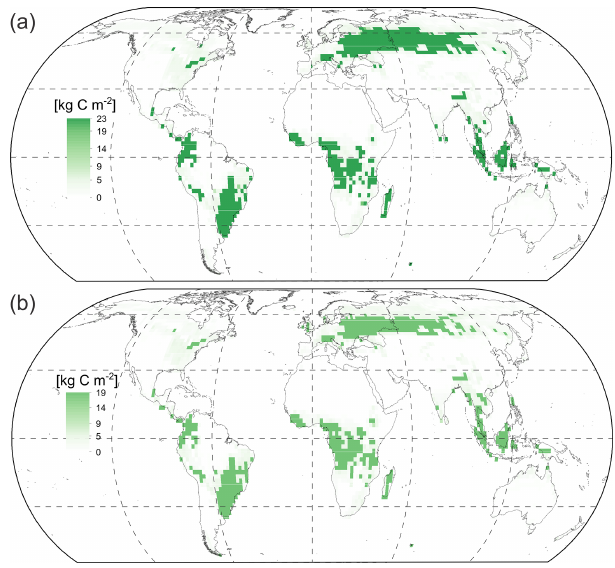
Figure 2. Carbon sequestered in different afforestation– reforestation scenarios for the 21st century period (2006–2099) for an RCP4.5 scenario, according to Kracher (2017). (a) For an N-unlimited AR scenario the global C sequestration is